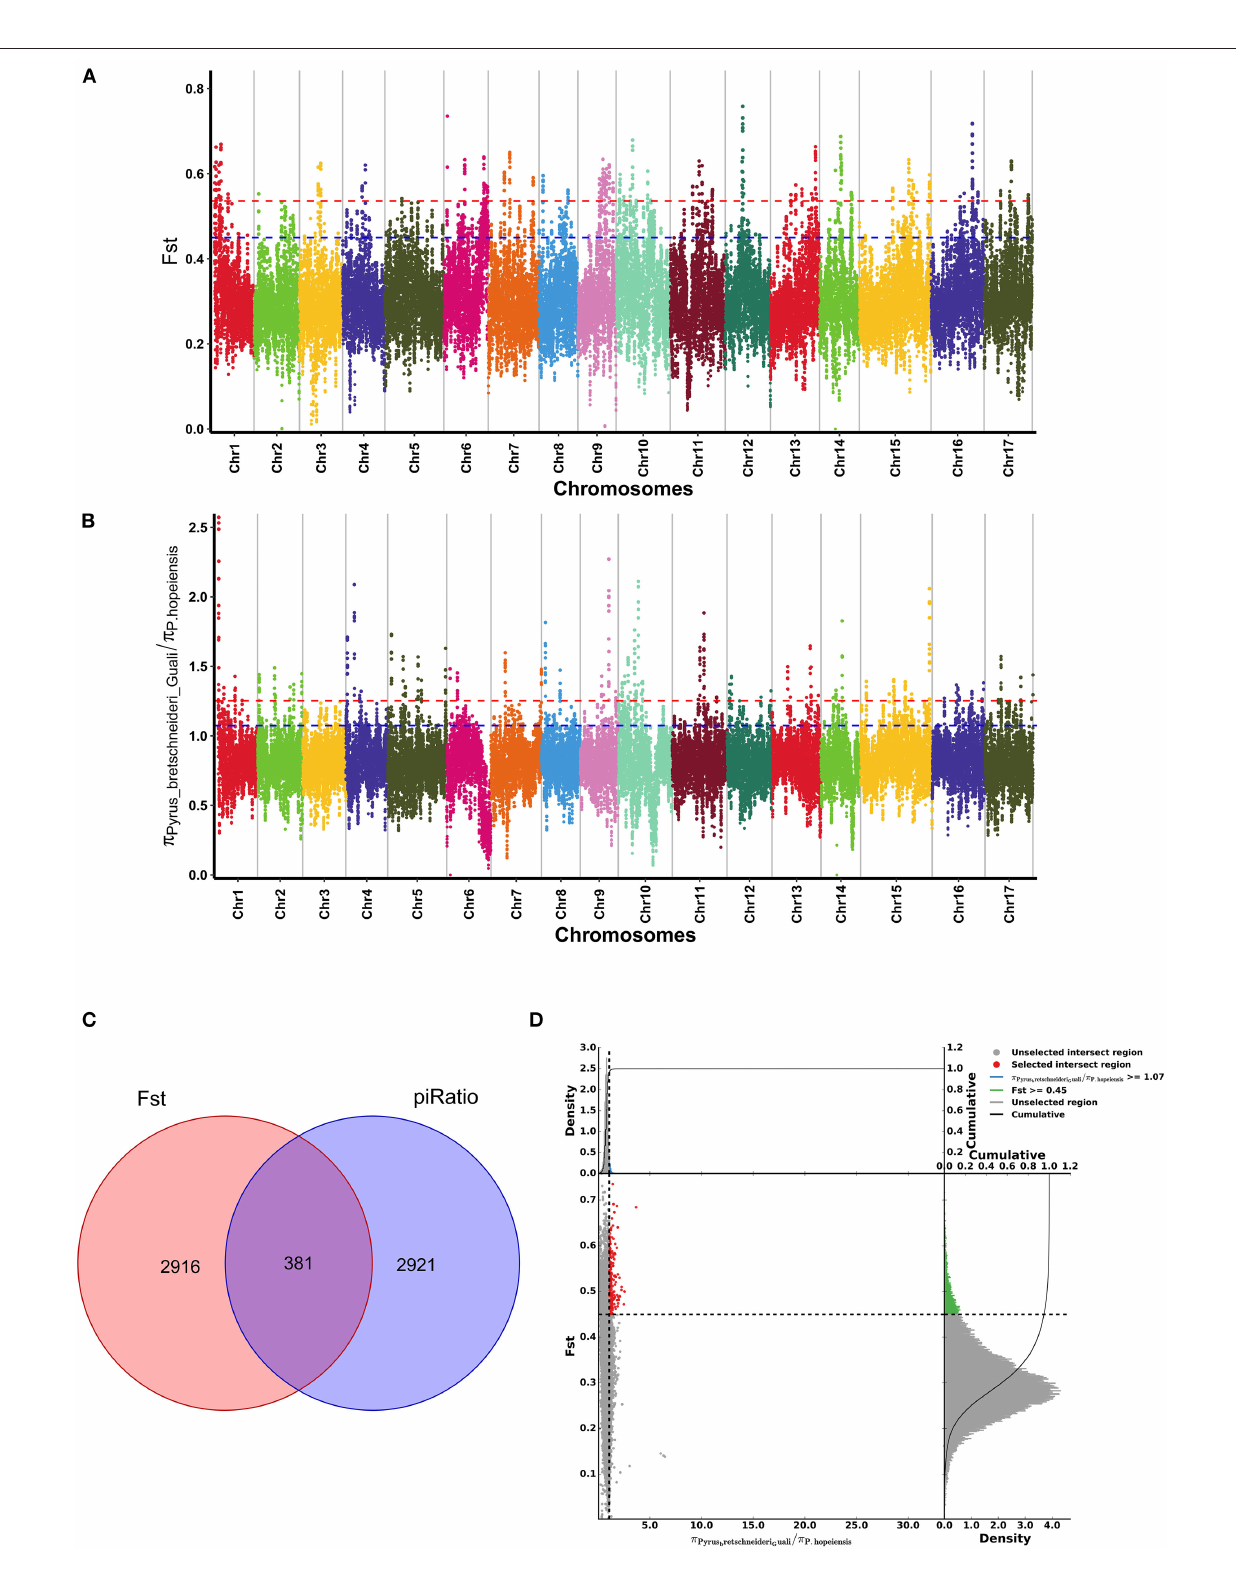
Frontiers in Plant Science |